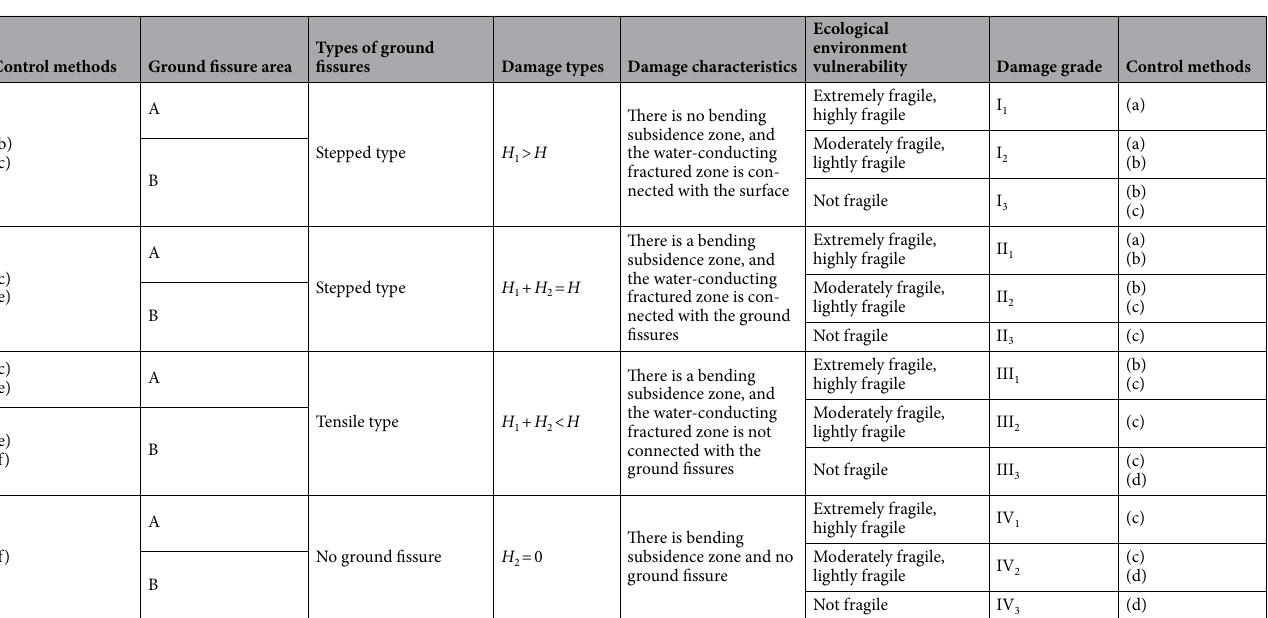
Table 3. Surface damage assessment system and control method of high-intensity mining 49 . A: Boundary permanent fissures zone; B: Middle dynamic fissures zone; (a) No mining; (b) Fully filled mining; (c) Partial filling, coal pillar retaining, height limited mining and grouting in key strata; (d) Direct mining; (e) Artificial landfill; (f)